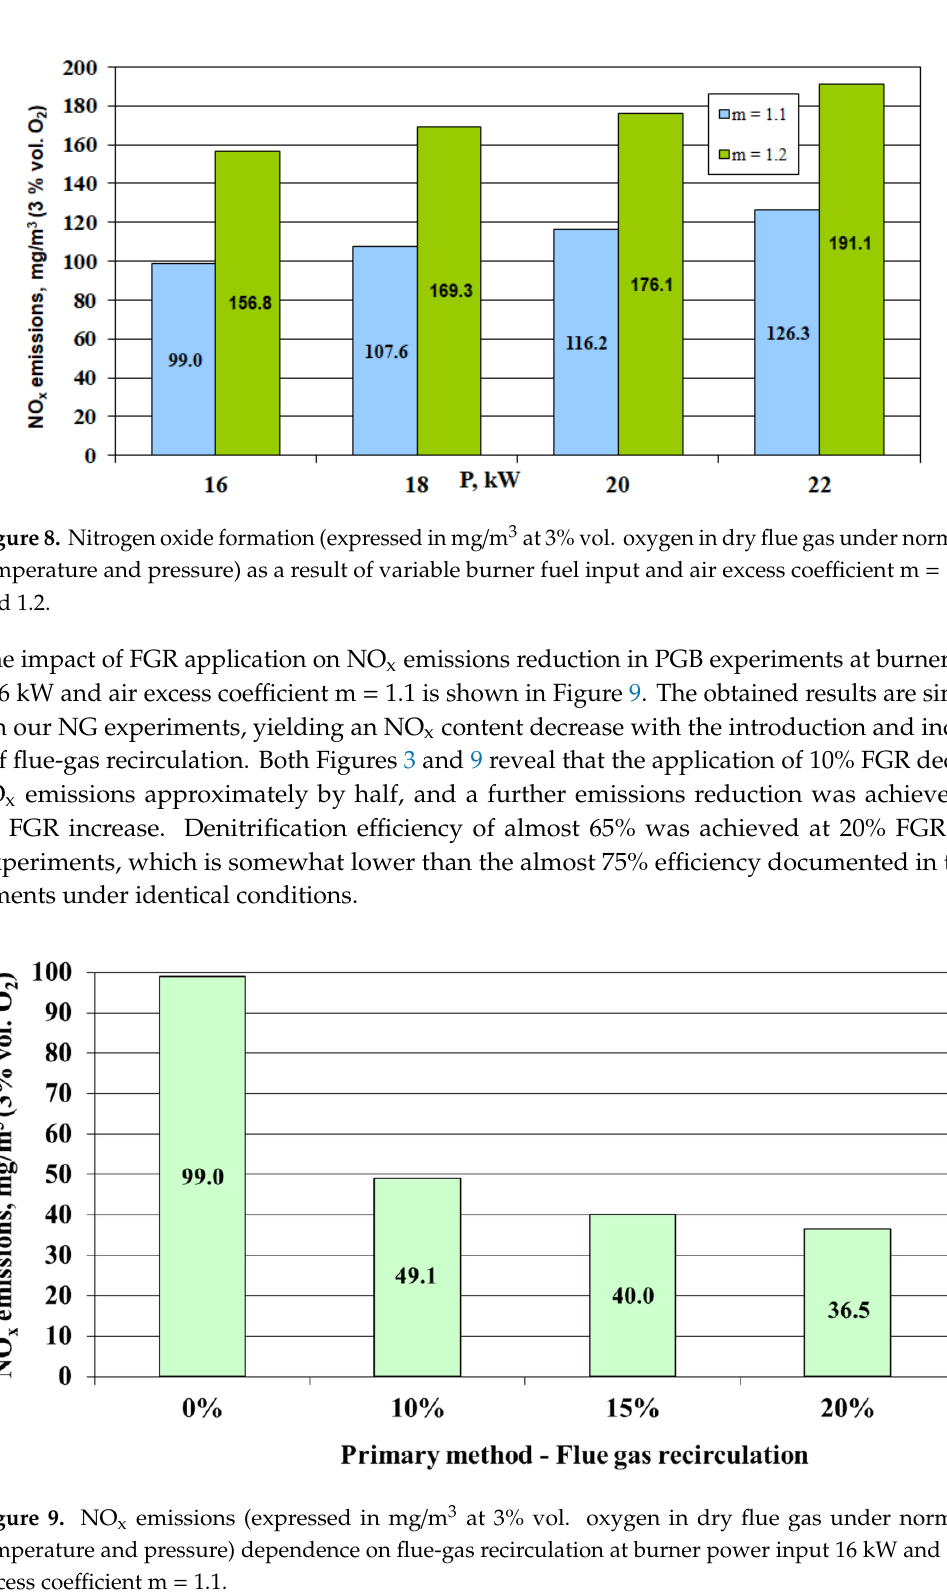
Figure 10. Effect of increasing flue-gas recirculation share on the course of the temperature field through the furnace at burner power input 16 kW and air excess coefficient m = 1.1.